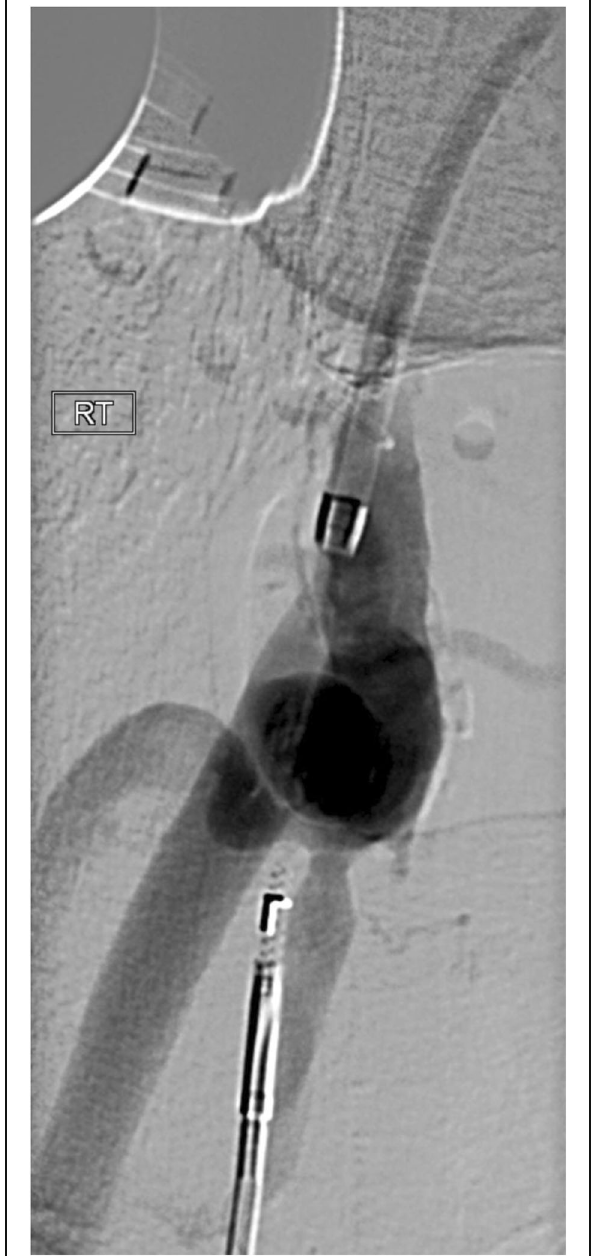
Fig. 4 Outback catheter re-entry device positioned at the level of the superficial femoral artery stump before successful re-entry into that